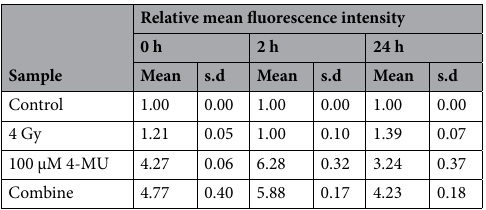
Table 2. Raw data of relative mean fluorescence intensity measured by flowcytometry. DCFDA fluorescence intensity 0, 2, and 24 h after treatment is shown.